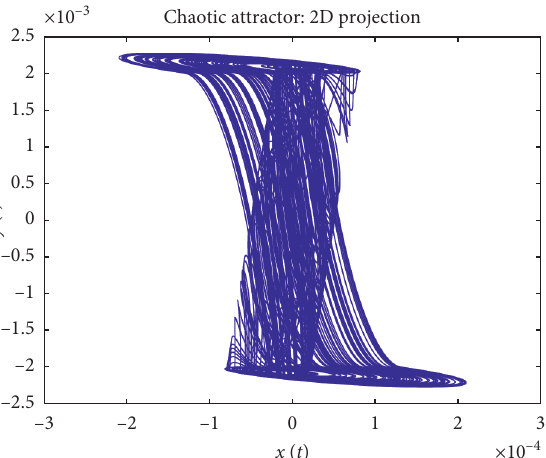
Figure 2: Chaotic attractor based on encryption